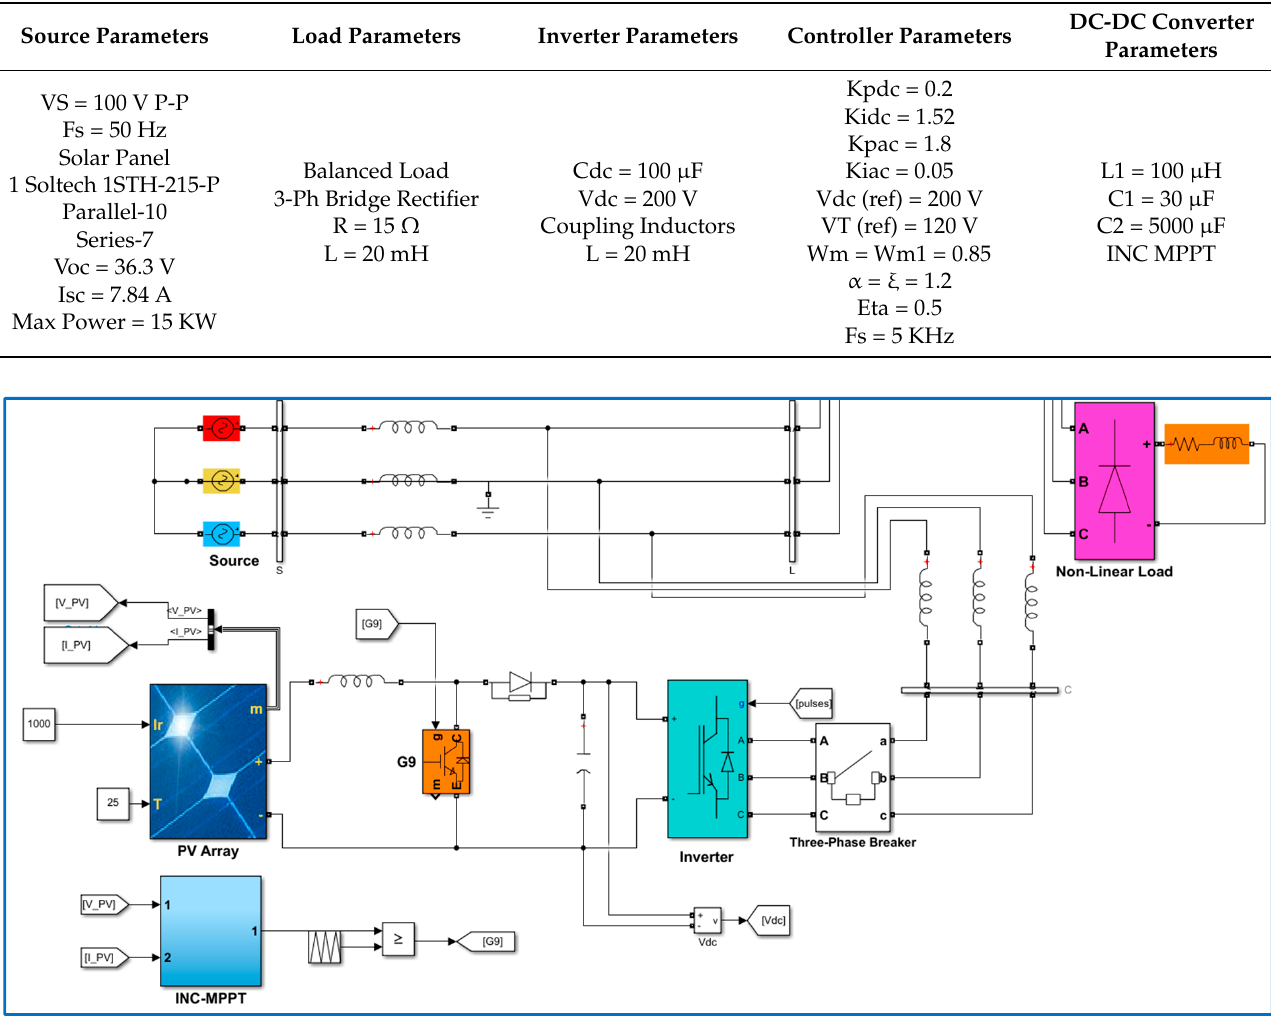
Figure 10. Simulink model of the grid-tied solar PV system.